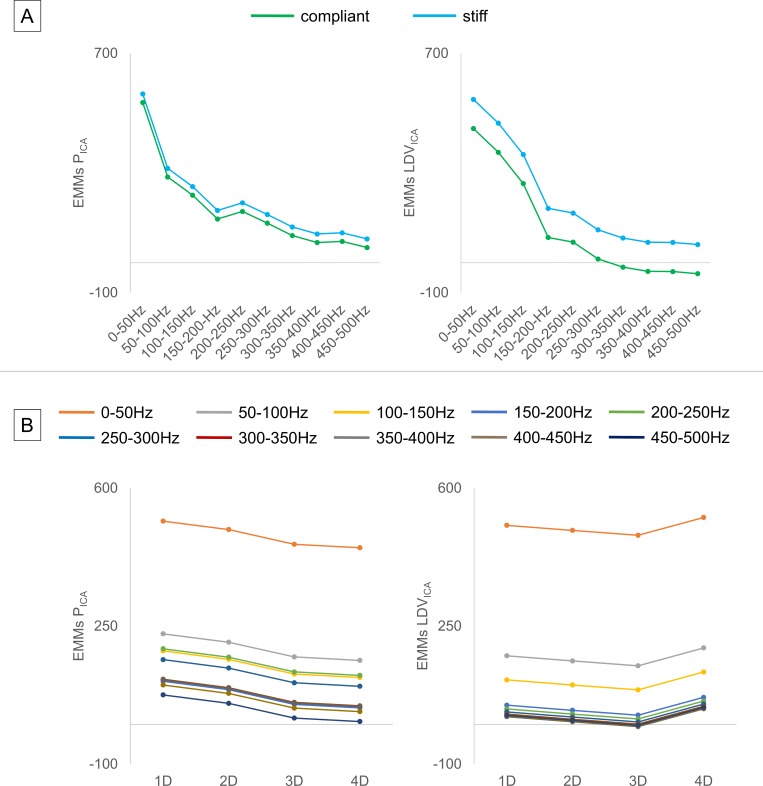
Estimated Marginal Means (EMMs).(A) The stiff model lead to higher EMMs for both the integrals of normalized spectra of pressure and LDV in the ICA (PICA and LDVICA, respectively). (B) The EMMs decreased while moving further downstream from the stenosis for the pressure, and this trend was not as marked for the LDV where the 4D signal was above the 1D level.